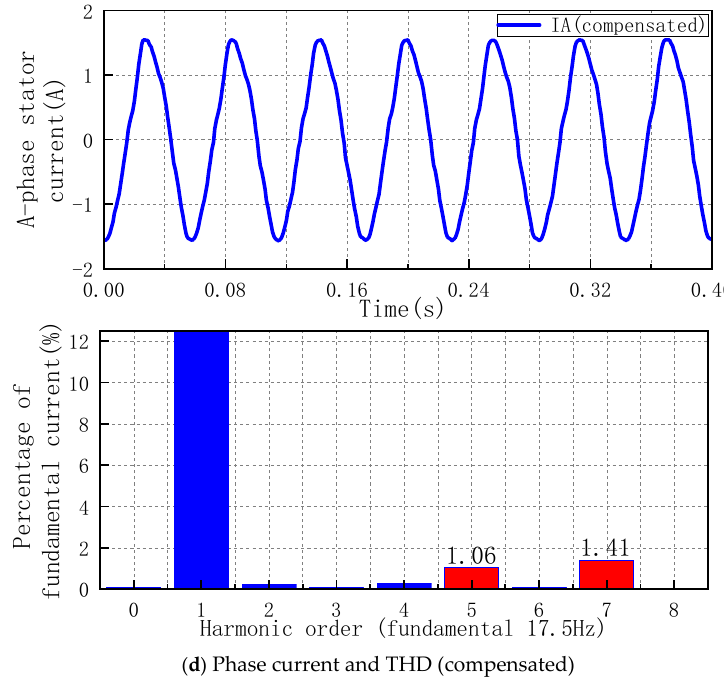
Figure 15. Experiment data for 350 rpm condition.